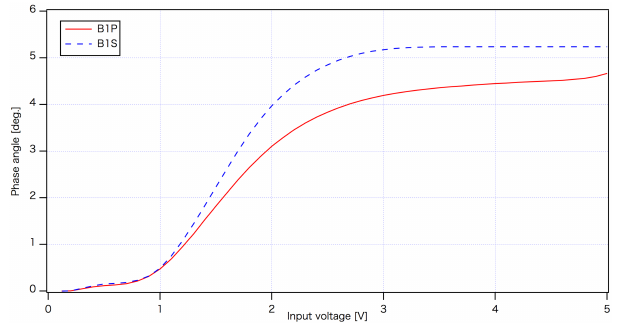
Figure 12. Weighting function for interferogram with bias larger than 100 half laser